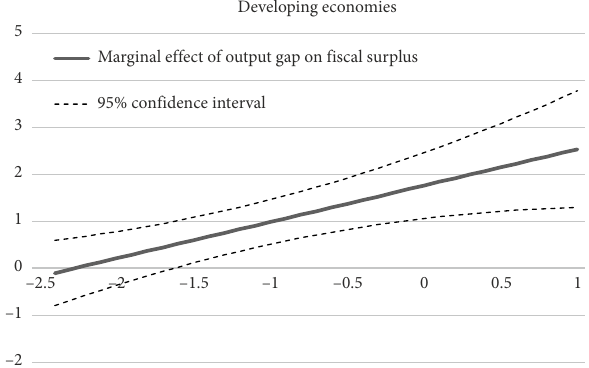
Figure 3. Marginal effect of the output gap on total surplus conditional on government effectiveness in developing